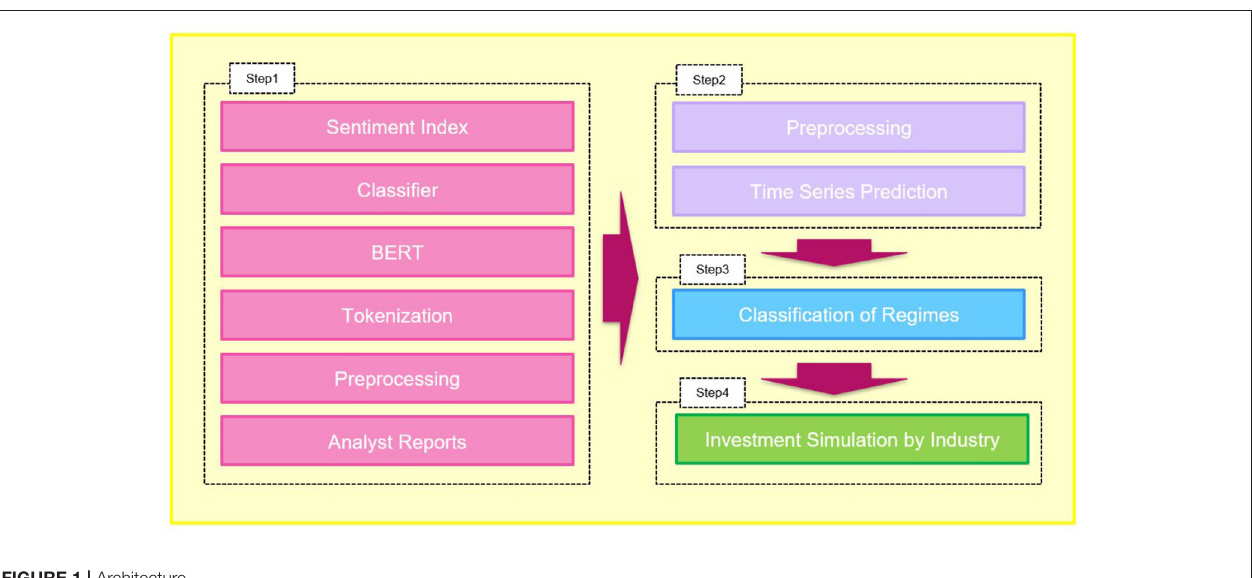
FIGURE 1 | Architecture.